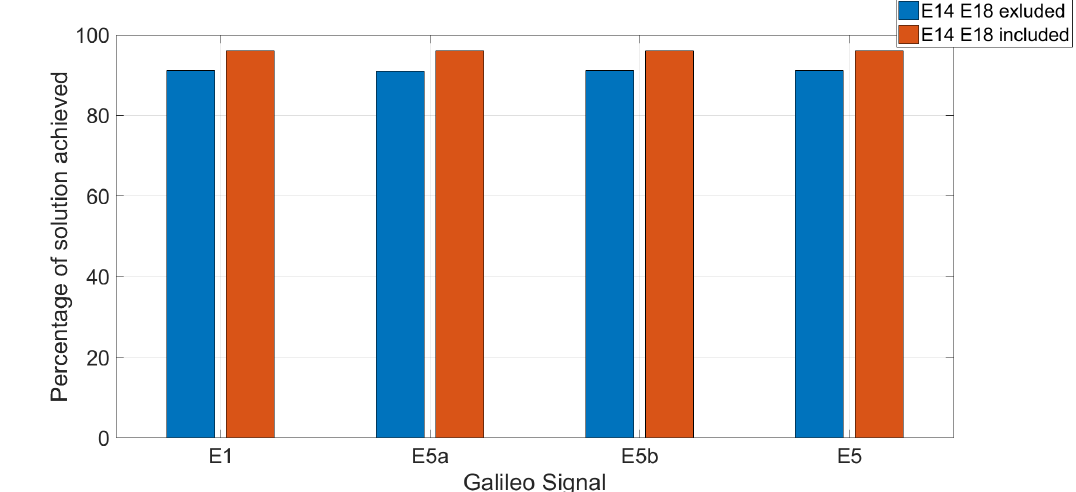
Figure 9. Percentage of Galileo constellation achieved positioning solutions in the YEL2 location excluding (blue bars) and including (red bars) the Milena (E14) and Doresa (E18) satellites for the E1, E5a, E5b, and E5 Galileo signal. The analysis was carried out on 1,728,000